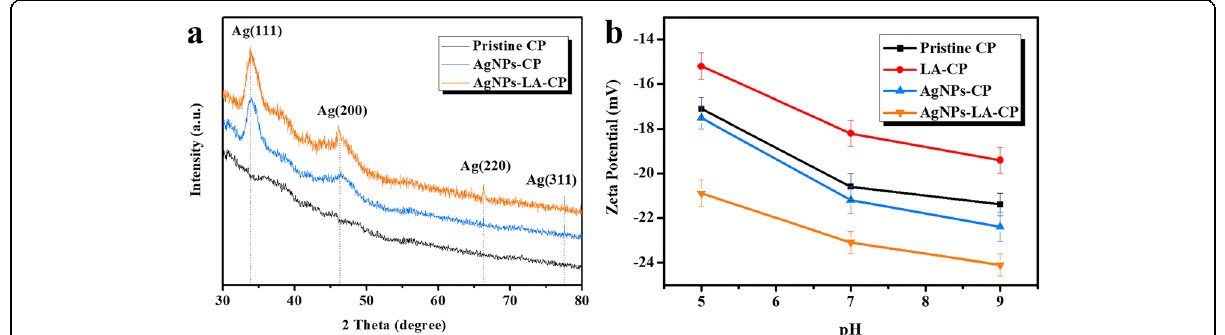
Fig. 7 a XRD patterns and b Surface ζ -potential of different samples